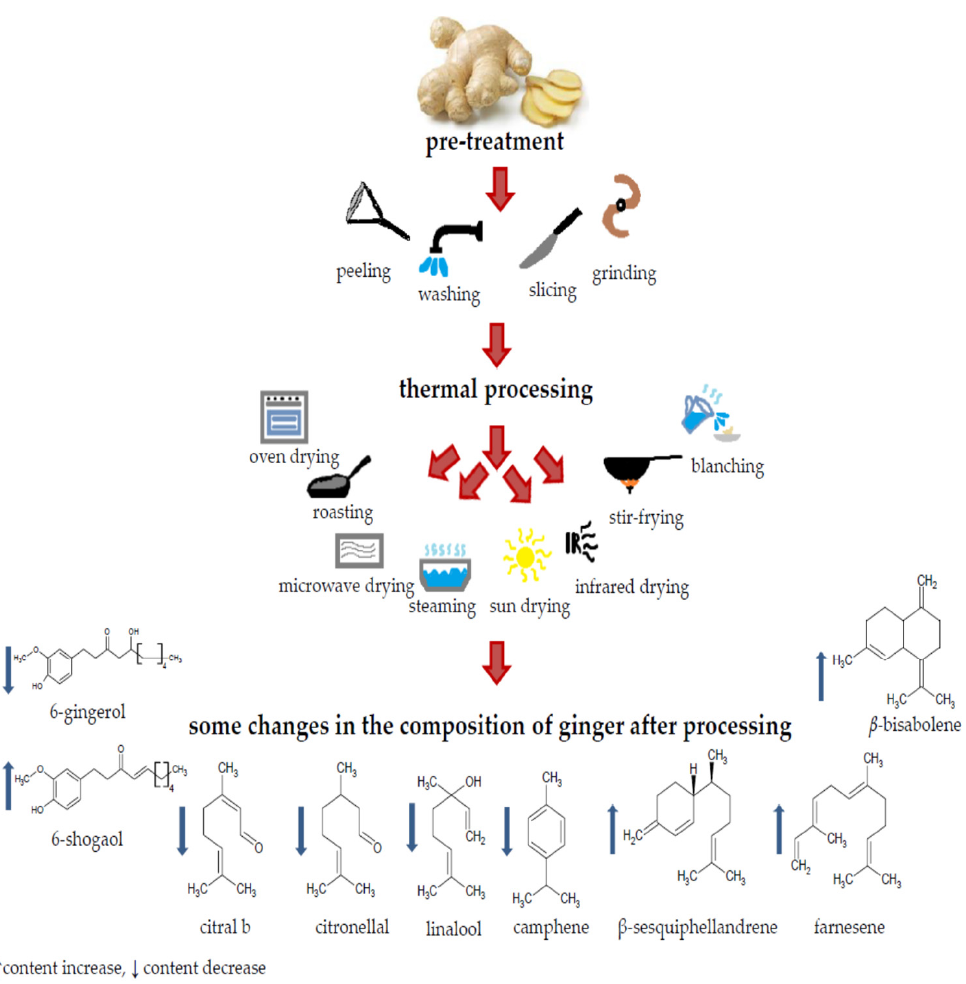
Figure 1. Schematic drawing of ginger processing.